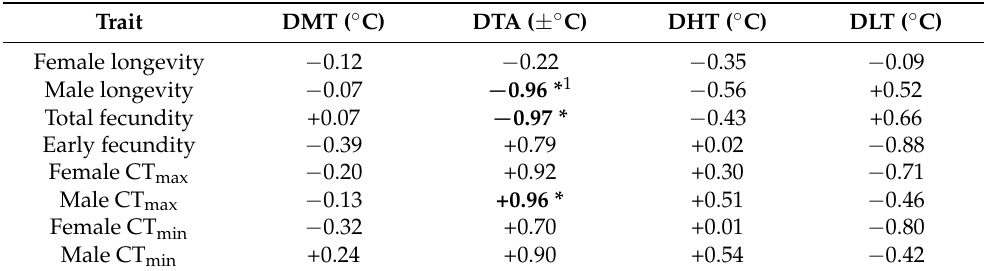
Table 2. Results of the Pearson correlation coefficient among Plutella xylostella traits and temperature